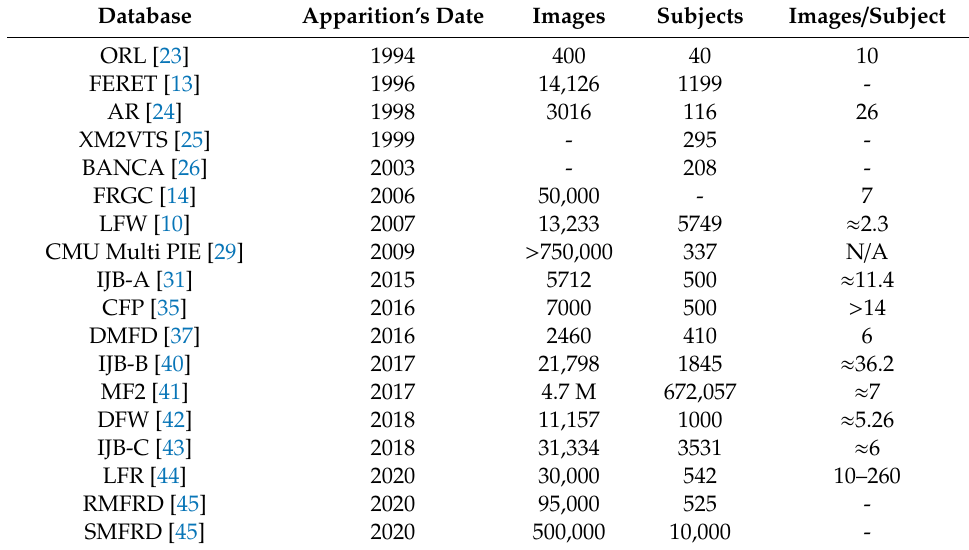
Figure 18. Example images from SMFRD (simulated masked face recognition dataset) dataset: Table 1. Comparative summary of the most well-known / recent 2D face recognition datasets used for Table 1. Comparative summary of the most well-known/recent 2D face recognition datasets used for simulated masked images. training and / or testing face recognition systems. training and/or testing face recognition systems.